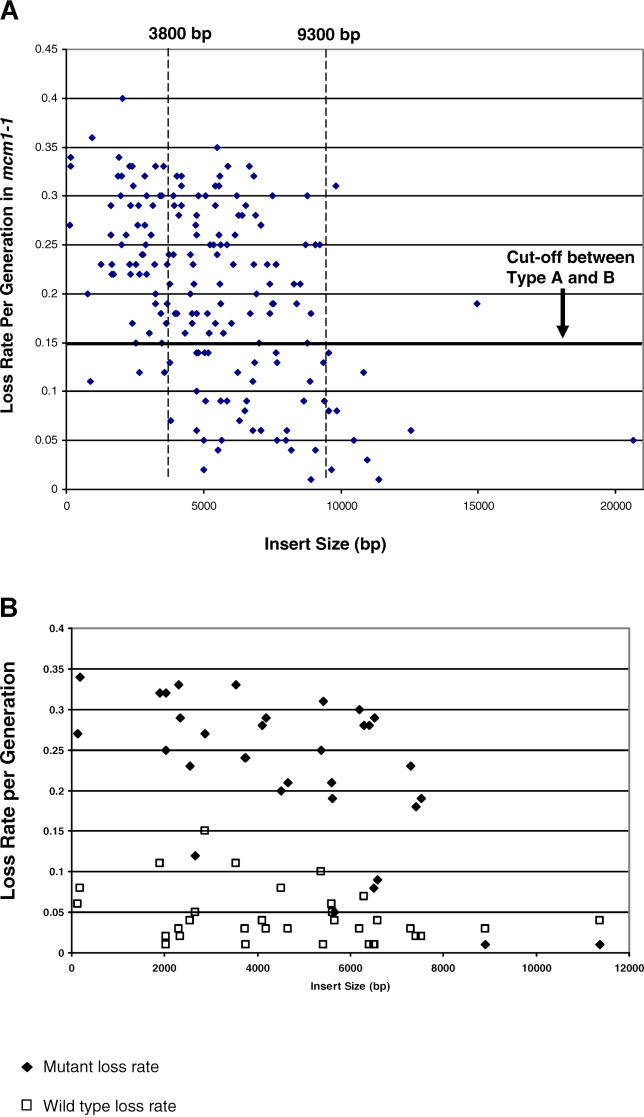
Characterization of A-Type and B-Type ARSs(A) Effect of insert size on plasmid stability. Loss rates of plasmids per cell division in mcm1–1 cells plotted against insert size. Only inserts between 3,800 and 9,300 bp were analyzed further.(B) Stability of plasmids was measured in mutant (black diamonds) and wild-type (white squares) cells.